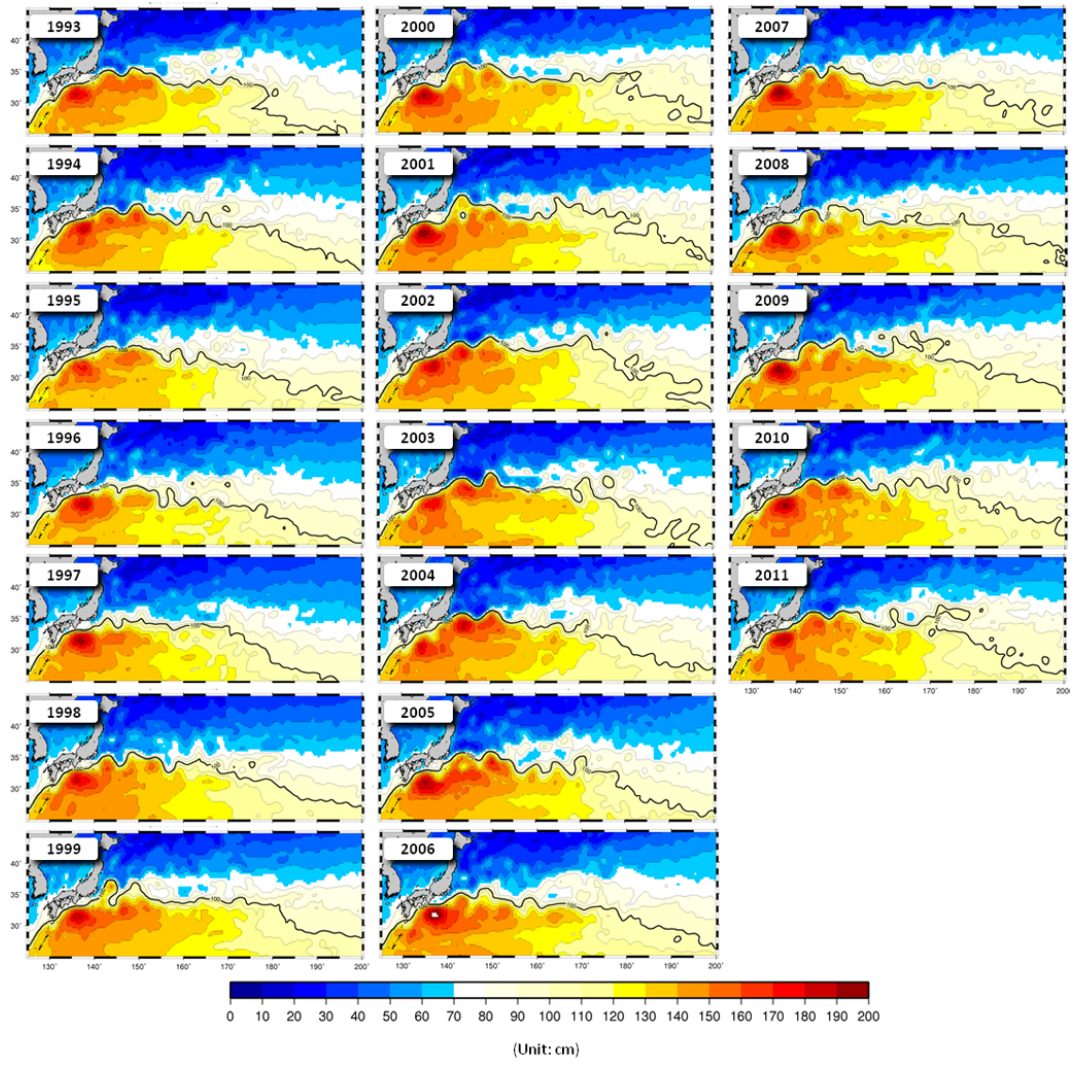
Fig. 7. Yearly averaged ADT with a 10cm contour interval and a thick line denoting 100cm in the KE region from year 1993 (upper left panel) to year 2011 (lower right panel). Data of the Near Real Time (NRT) production mode are used during year 2011, from 26 January to 30 November. Unit in